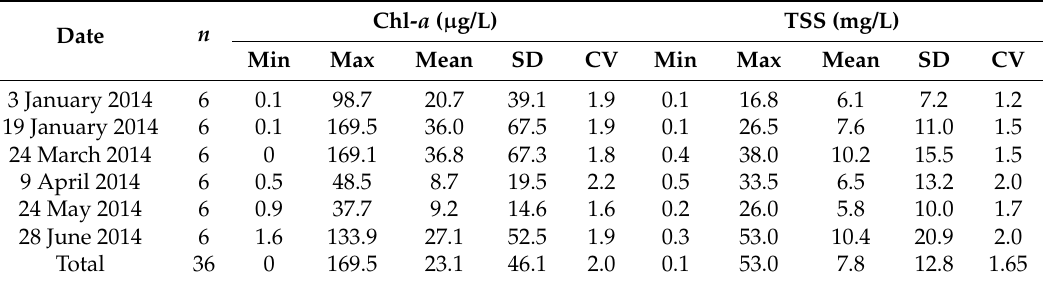
Table 2. Descriptive statistics for the Chl- a and TSS